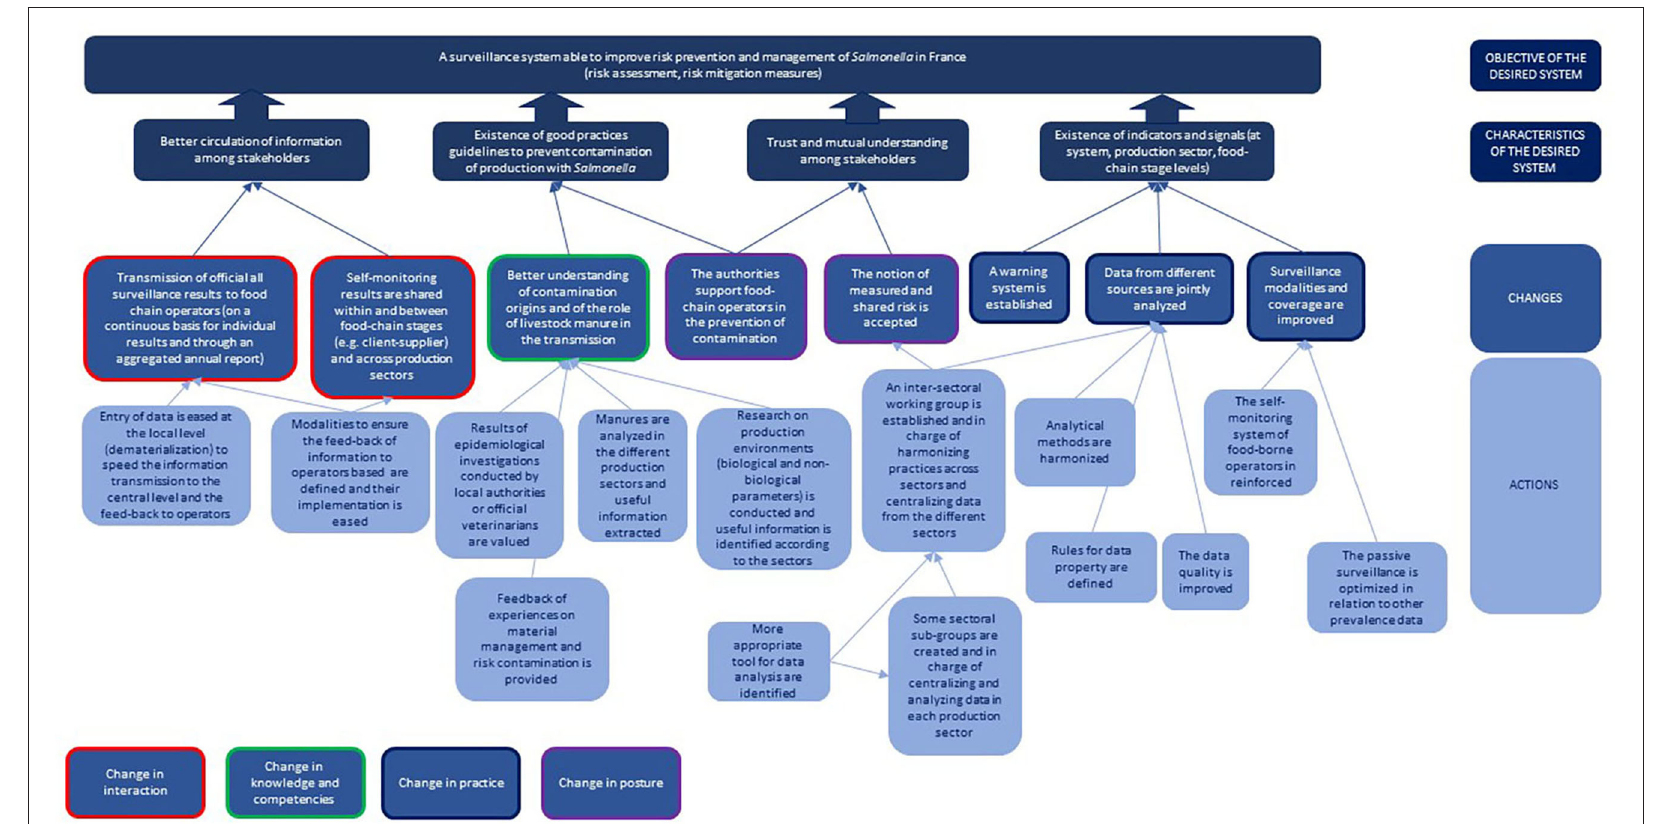
FIGURE 10 | The innovation pathway constructed by the participants to the participatory process in